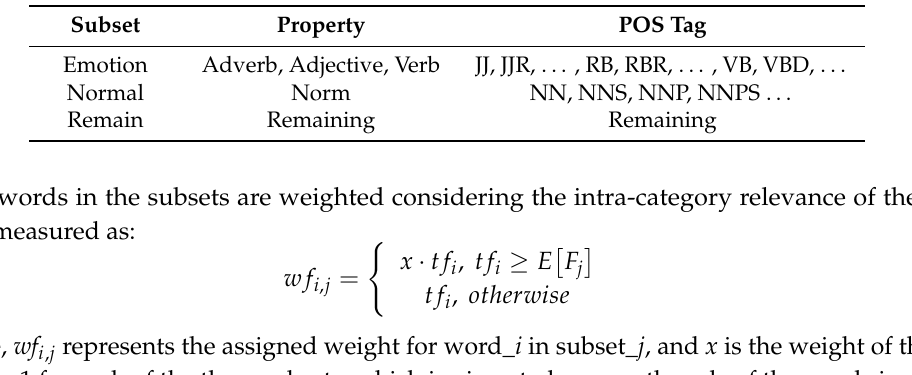
Table 1. The subsets with Part Of Speech (POS)